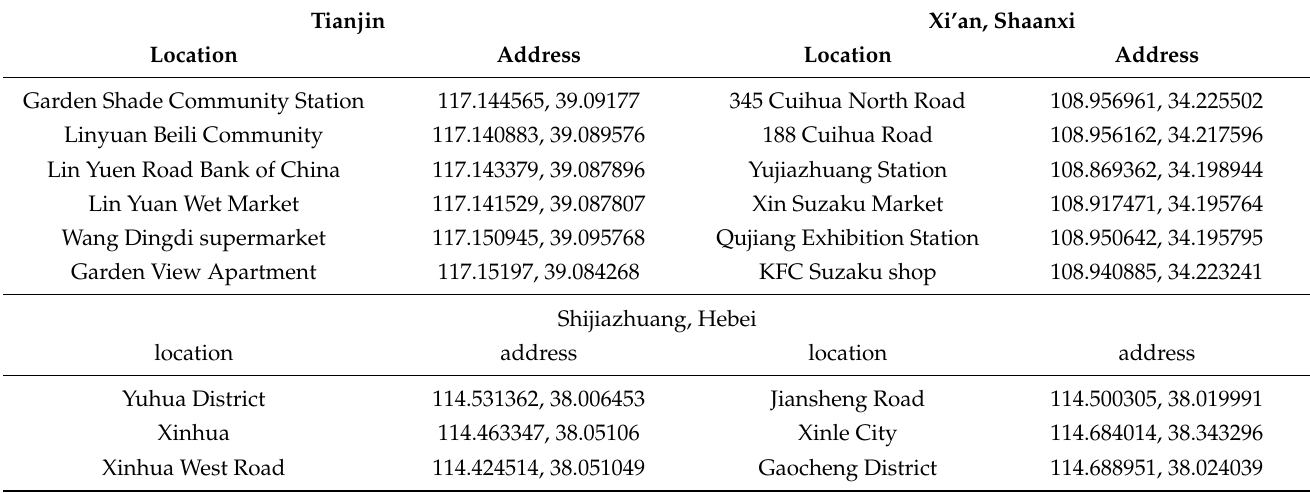
Figure 8. Heat map of trajectory data of each city. Table 1. Table of the most representative single patient